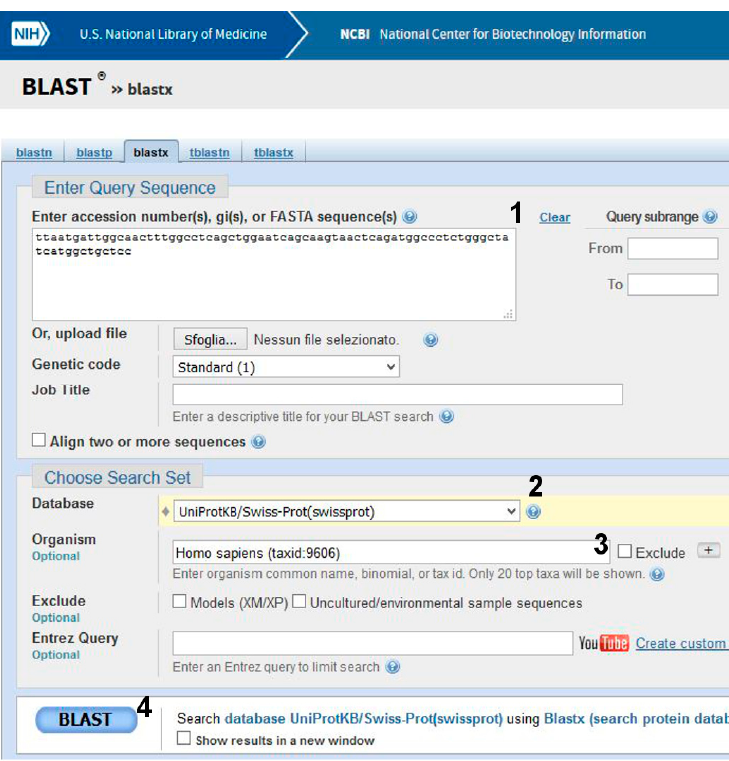
Figure 7. DNA analysis by using BlastX.